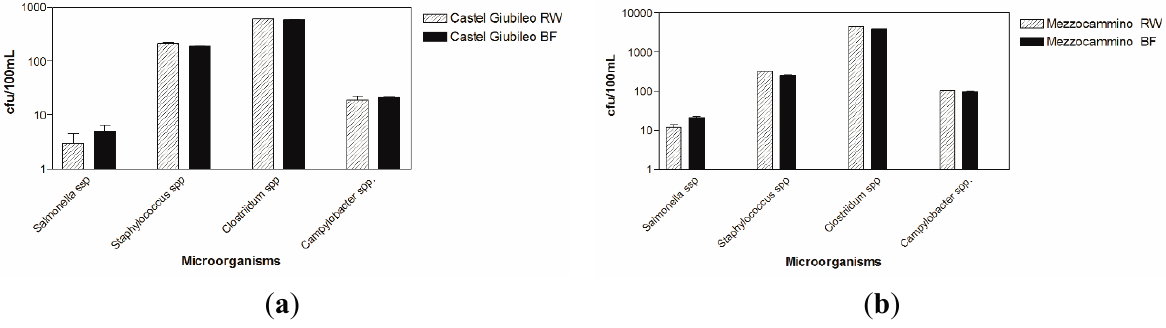
Figure 2. Each column represents a mean value of triplicate measurements of each microorganism, expressed as cfu /100 mL, detected at the Castel Giubileo site. ( a ) and Mezzocammino site ( b ). (Striped bar = raw water RW; Black bar = concentrated water